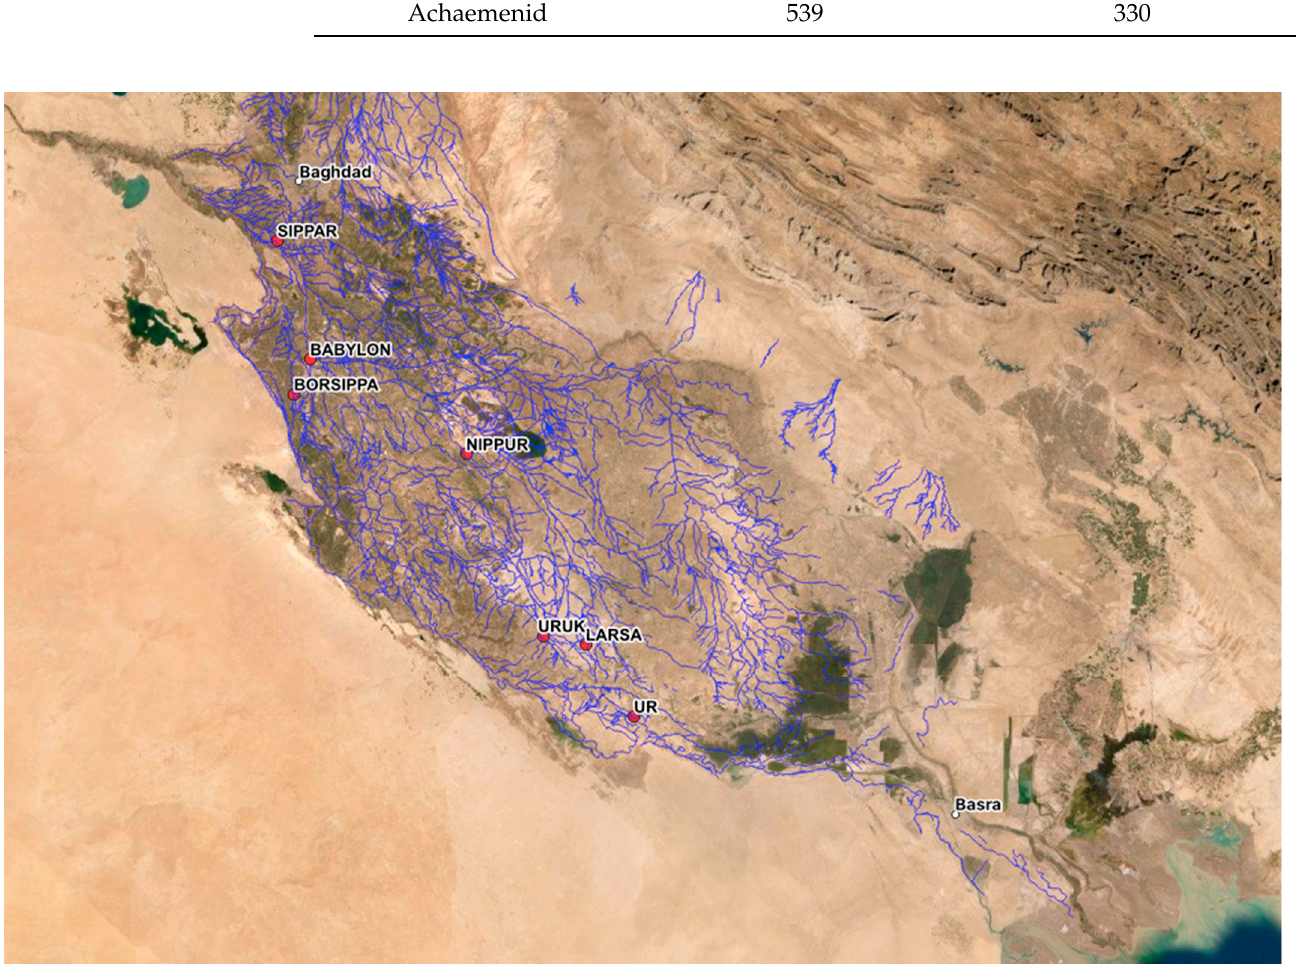
Figure 1. The Euphrates-Tigris Fluvial Delta. A general map of Ancient Mesopotamia showing purported channels and key sites. Based on data from Esri & Wikidata.